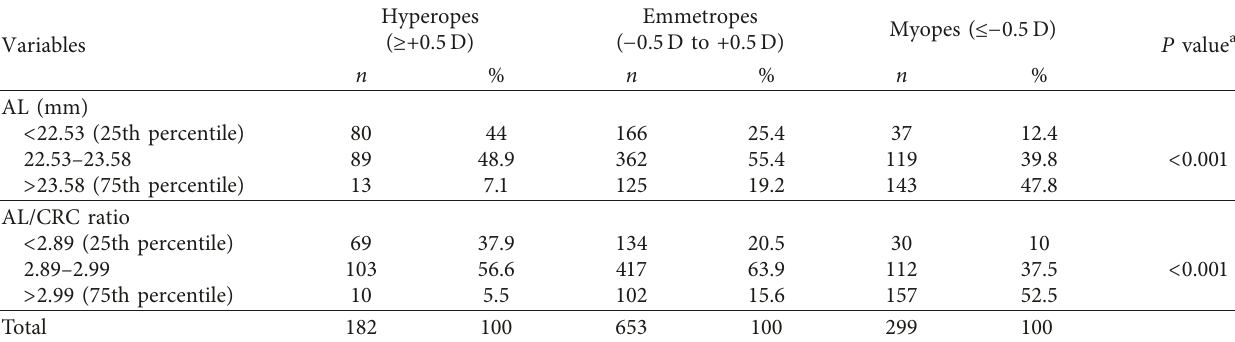
Table 4: Baseline ocular biometry percentages associated with refractive status of non-CSA children.